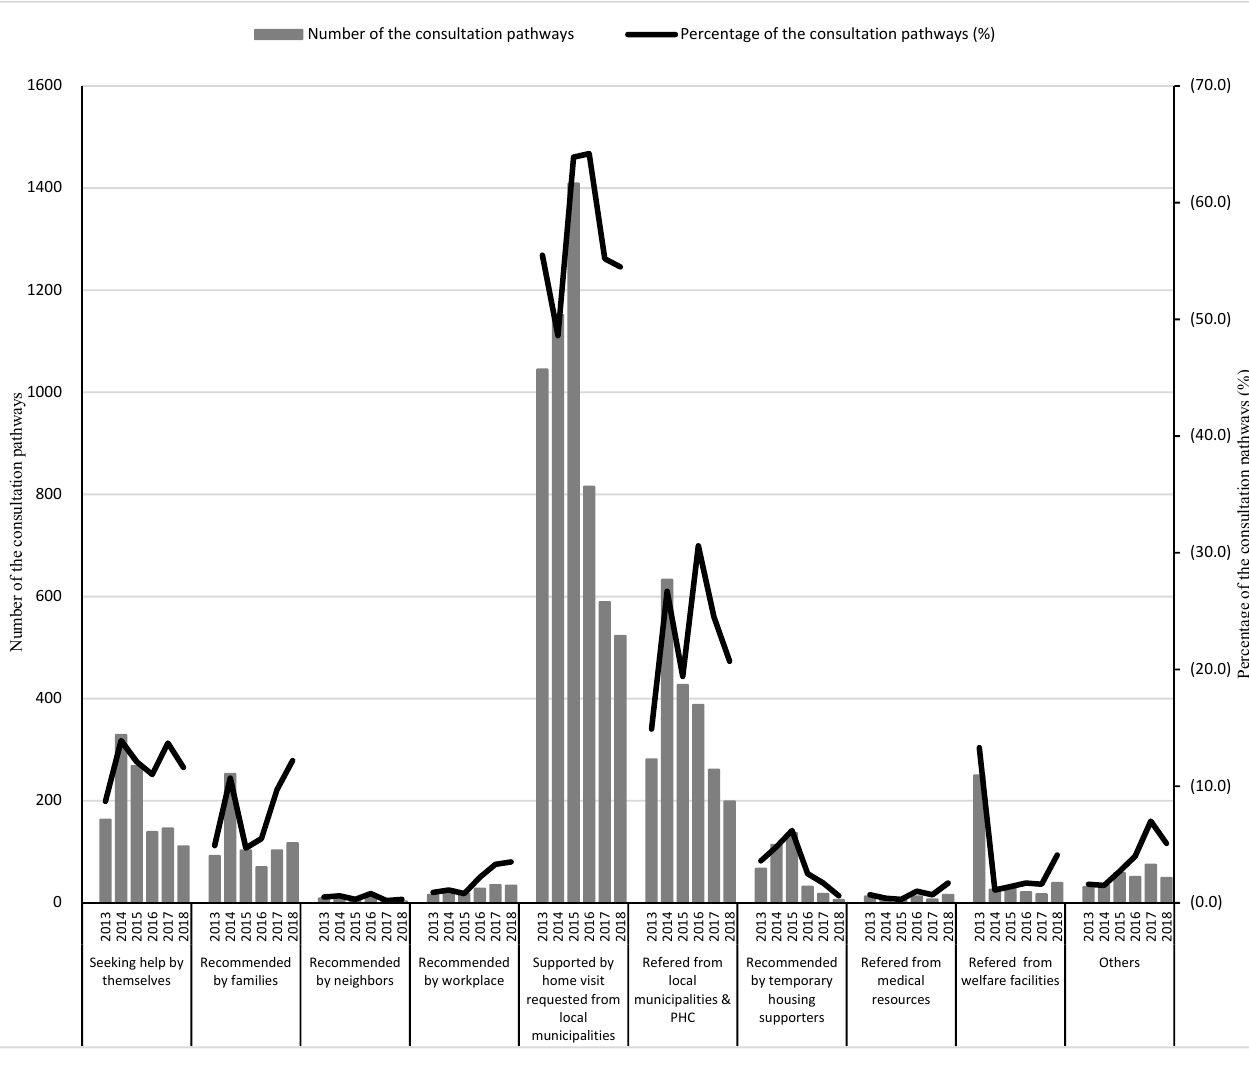
Figure 3. Number and percentage of the consultation pathways used. PHC, Public Health Center.